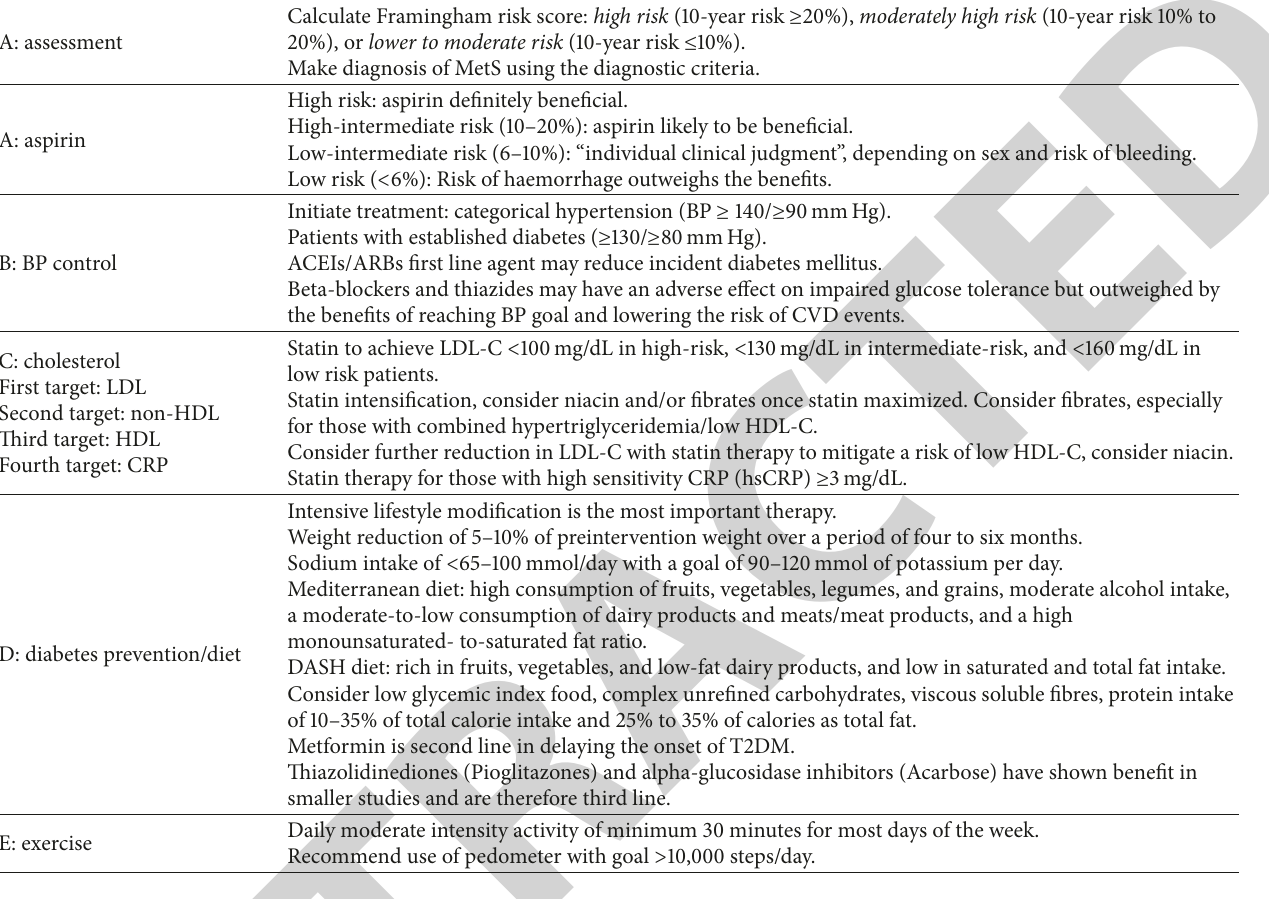
Table 4: Multidisciplinary approach to the